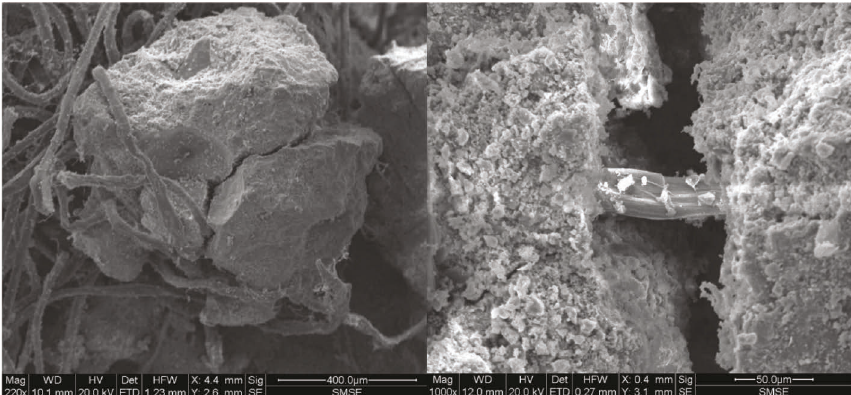
Figure 13: Microstructure of concrete material with polyethylene fiber [33].